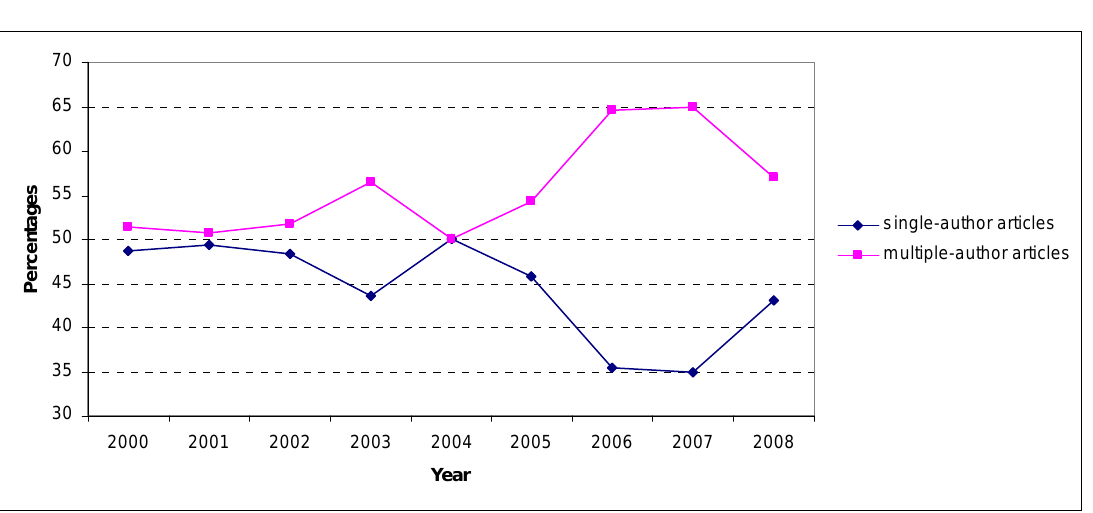
Figure 2 . Articles contributed by one author and multiple authors between 2000 and 2008 ( N =